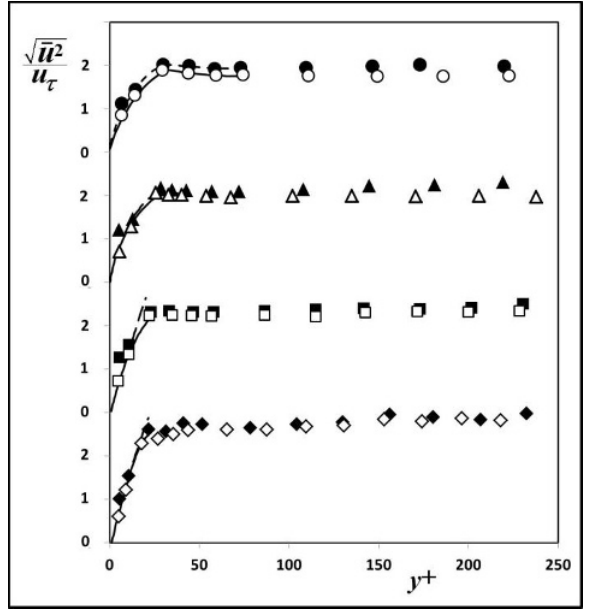
Fig. 7. Profiles of dimensionless standard deviation of velocity fluctuations normalized by inner variables (additional information in Table 1).